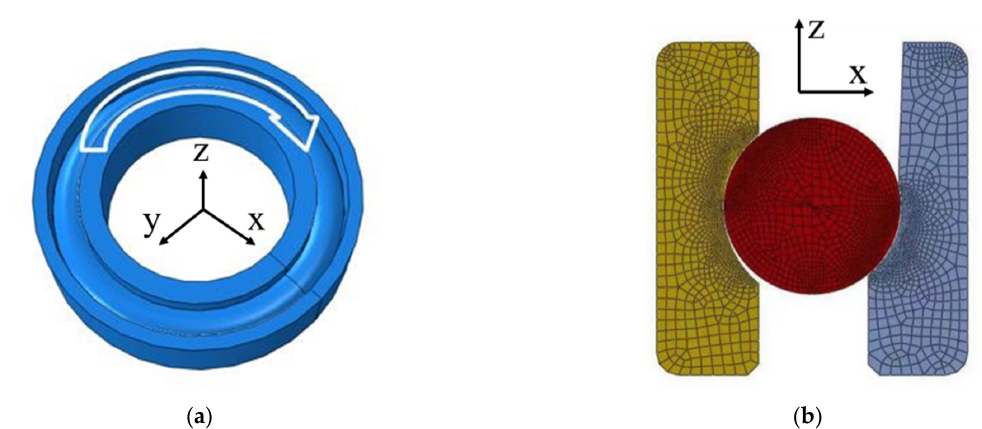
Figure 4. The equivalent 2D model of bearing. ( a ) The equivalent 3D bearing model in high speed. ( b ) The meshes of 2D bearing model. Table 5. Comparison of mesh parameters between 3D and 2D model of bearing.